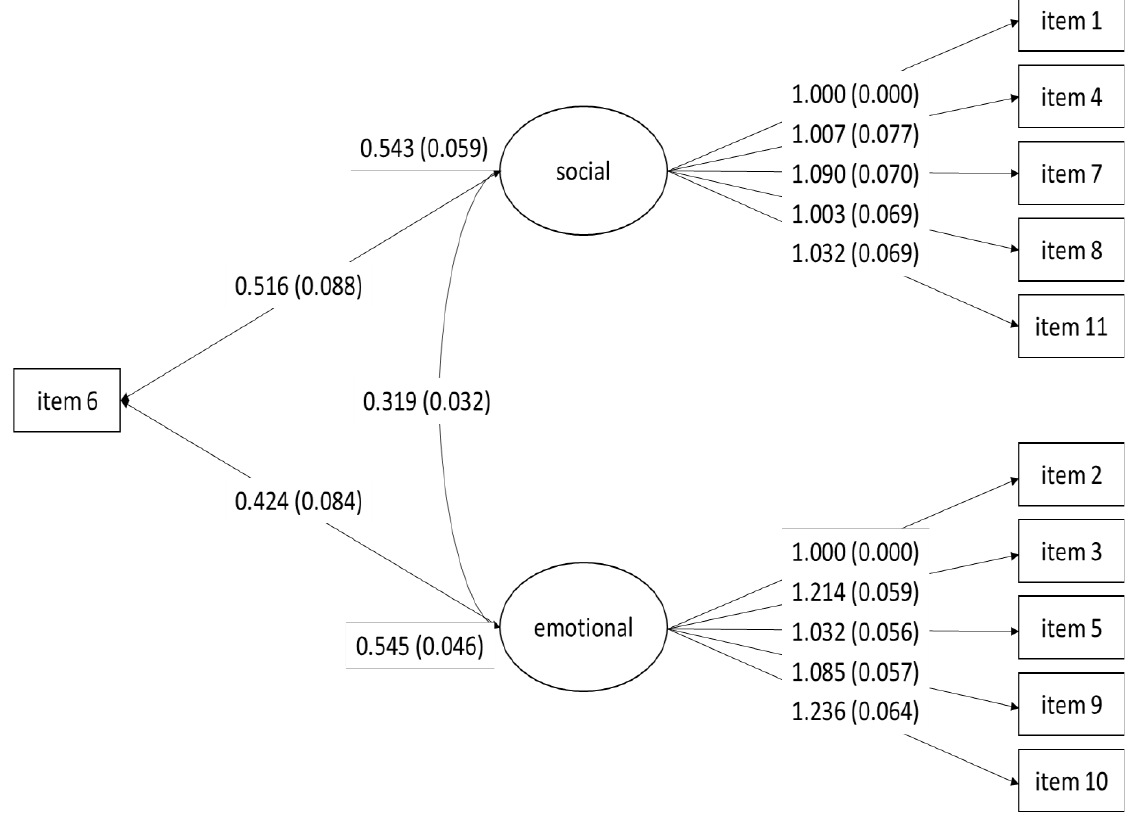
Figure 1. Confirmatory Factor Analysis of the two-factor model